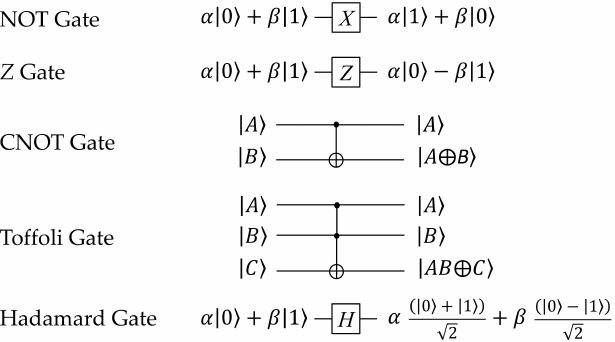
Figure 1. NOT, Z, CNOT, Toffoli, and Hadamard gates.